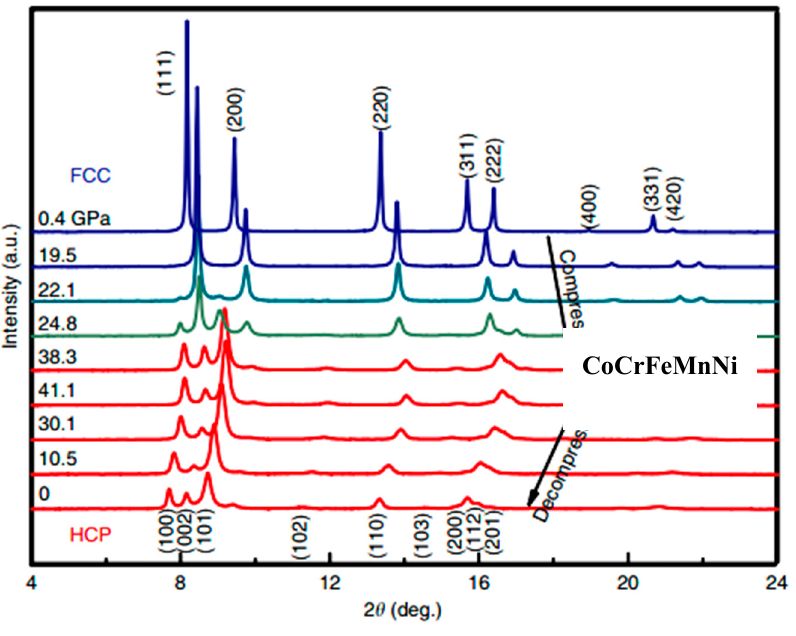
Figure 8. CoCrFeMnNi XRD patterns during compression and decompression, reproduced from [33], with permission from authors.